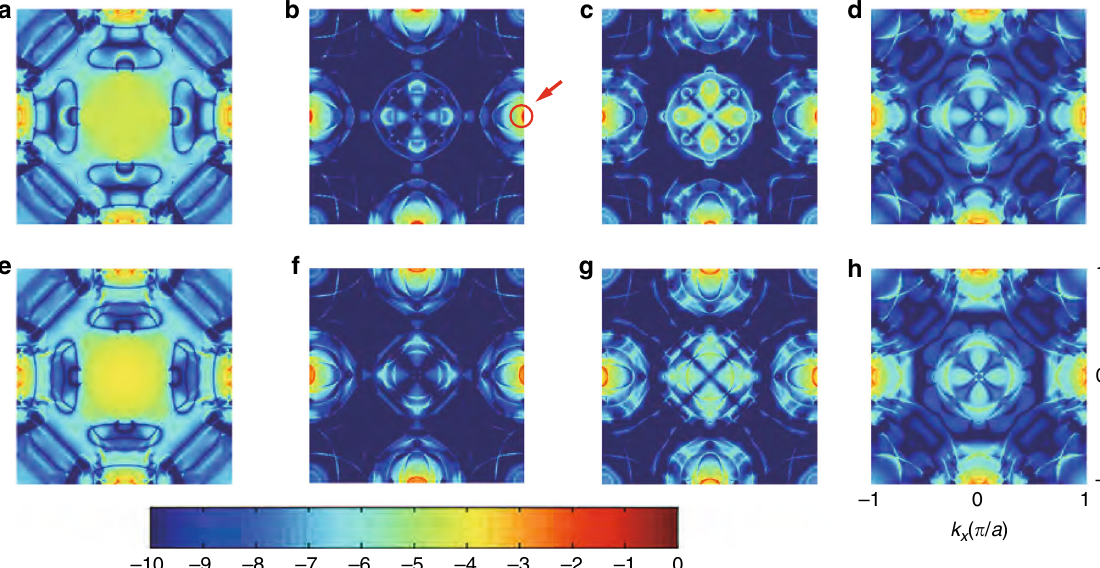
Fig. 4 Spin- and k || - resolved transmission coef fi cients. Transmission spectrums for p-MTJ stacks with a – d W, and e – h Ta spacer layers. a , e present the majority-to-majority conditions, and b , f the minority-to-minority conditions in P state; c , g present the majority-to-minority conditions, and d , h the minority-to-majority conditions in AP state